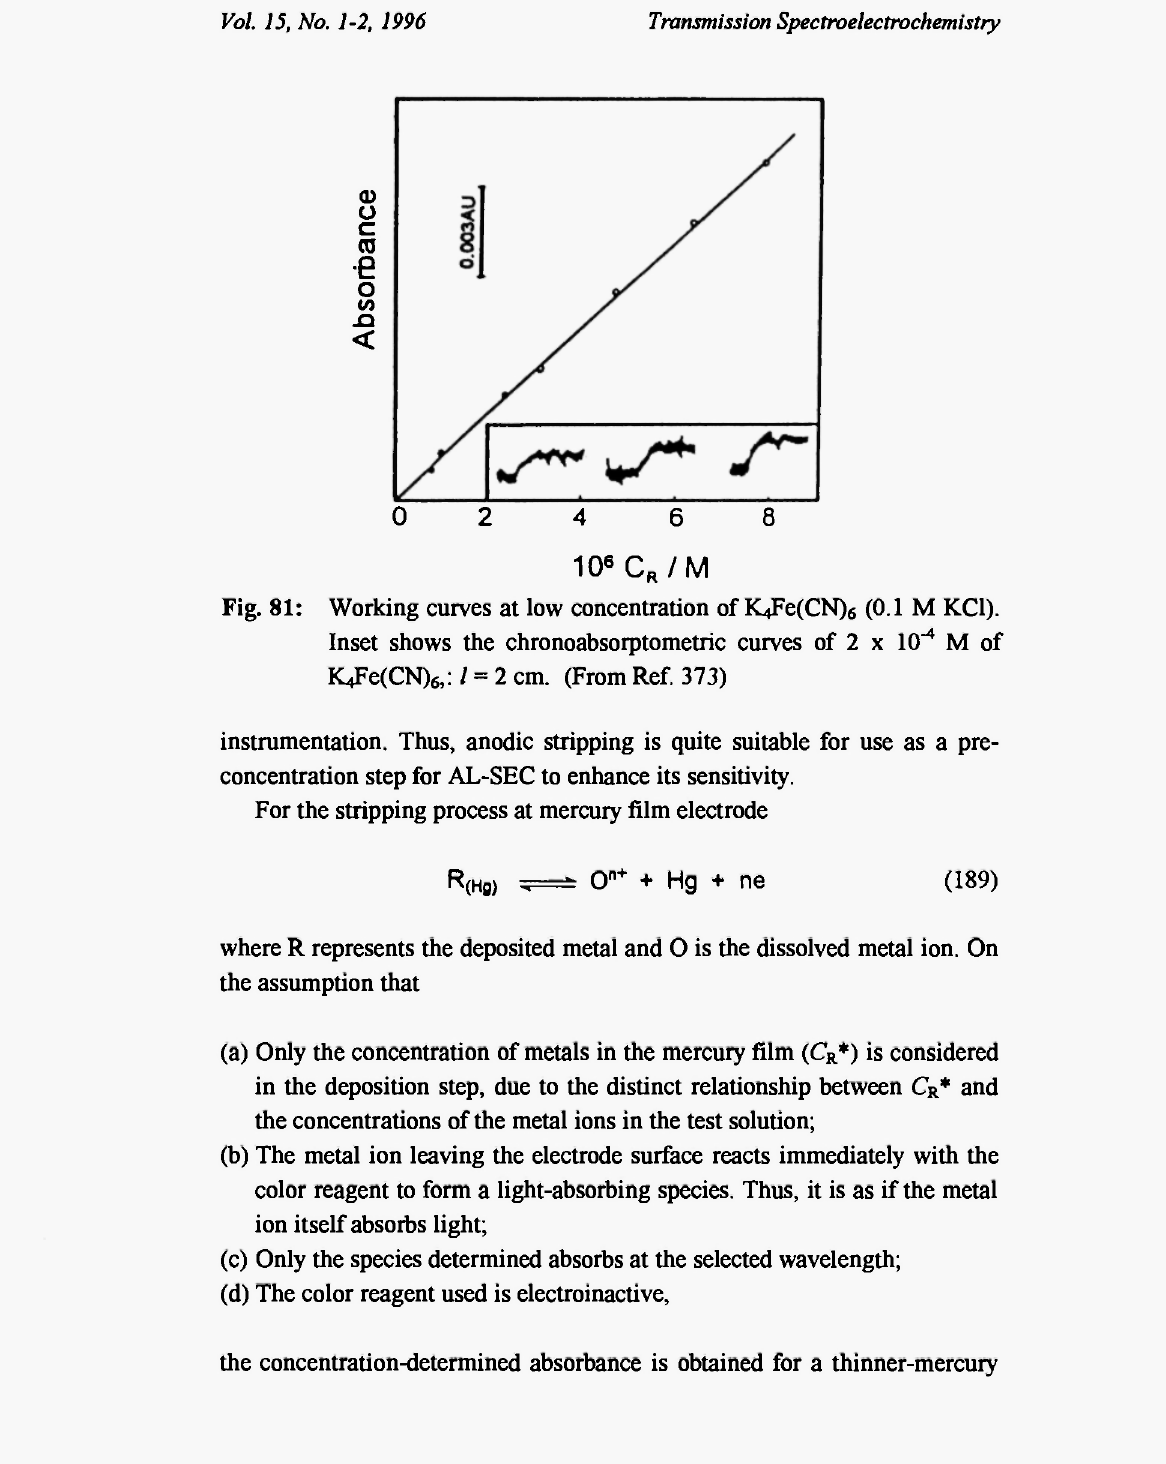
Fig. 81: Working curves at low concentration of K4Fe(CN) Inset shows the chronoabsorptometric curves of 2 χ ΙΟ" 4 Μ of K4Fe(CN) ,: / = 2 cm. (From Ref. 6